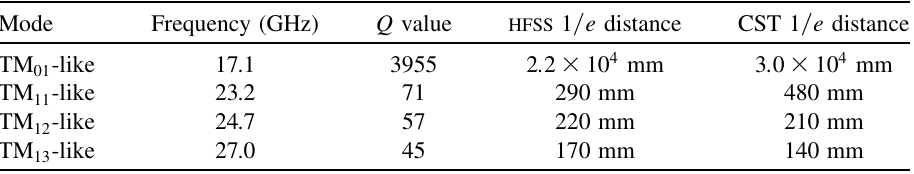
TABLE II. Comparison of 1 =e distances calculated from HFSS and CST simulation results.